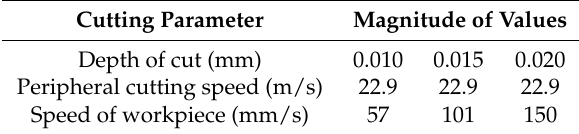
Table 1. Cutting conditions used during the experimental